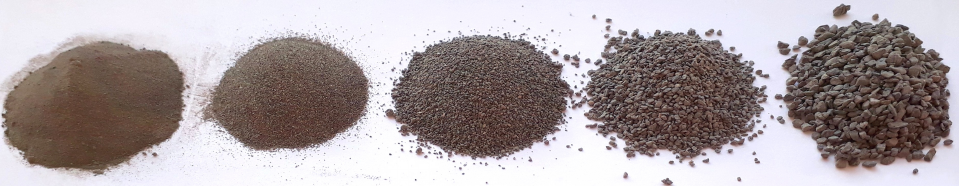
Figure 2. Dry samples of all individual size fractions of copper ore used in the experiments. From left to right: particles of size 0–0.1 mm; 0.1–0.2 mm; 0.2–0.5 mm; 0.5–1 mm; 1–2 mm.